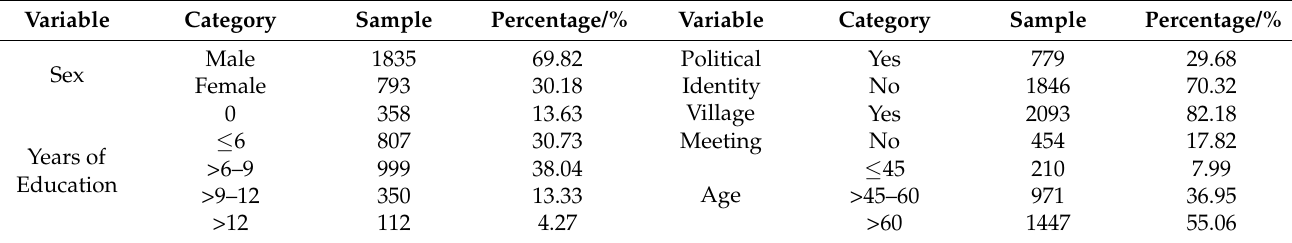
Table 1. Basic information of questionnaire